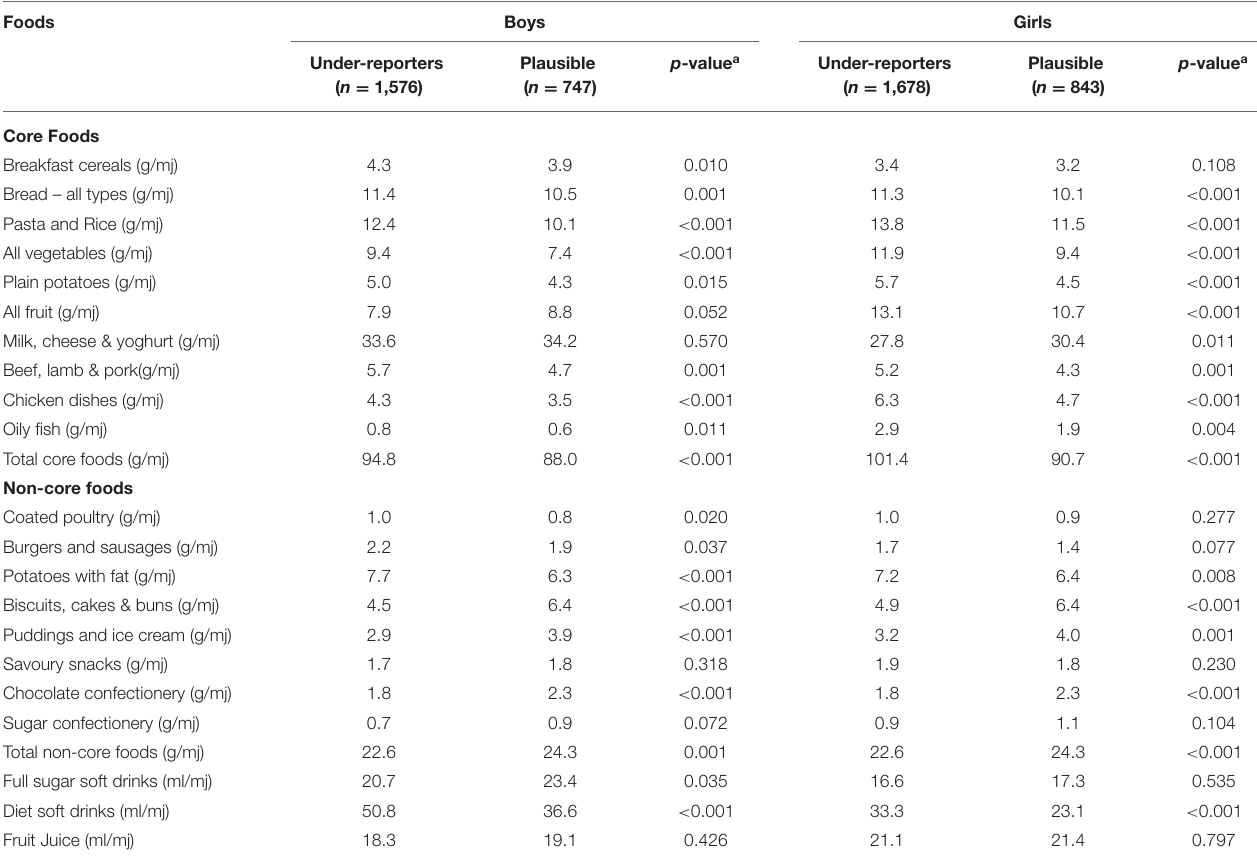
TABLE 4 | Mean weight of energy adjusted intakes of core foods, non-core foods (g/MJ) and drinks (ml/MJ) for under reporters compared to plausible reporters, stratified by sex.